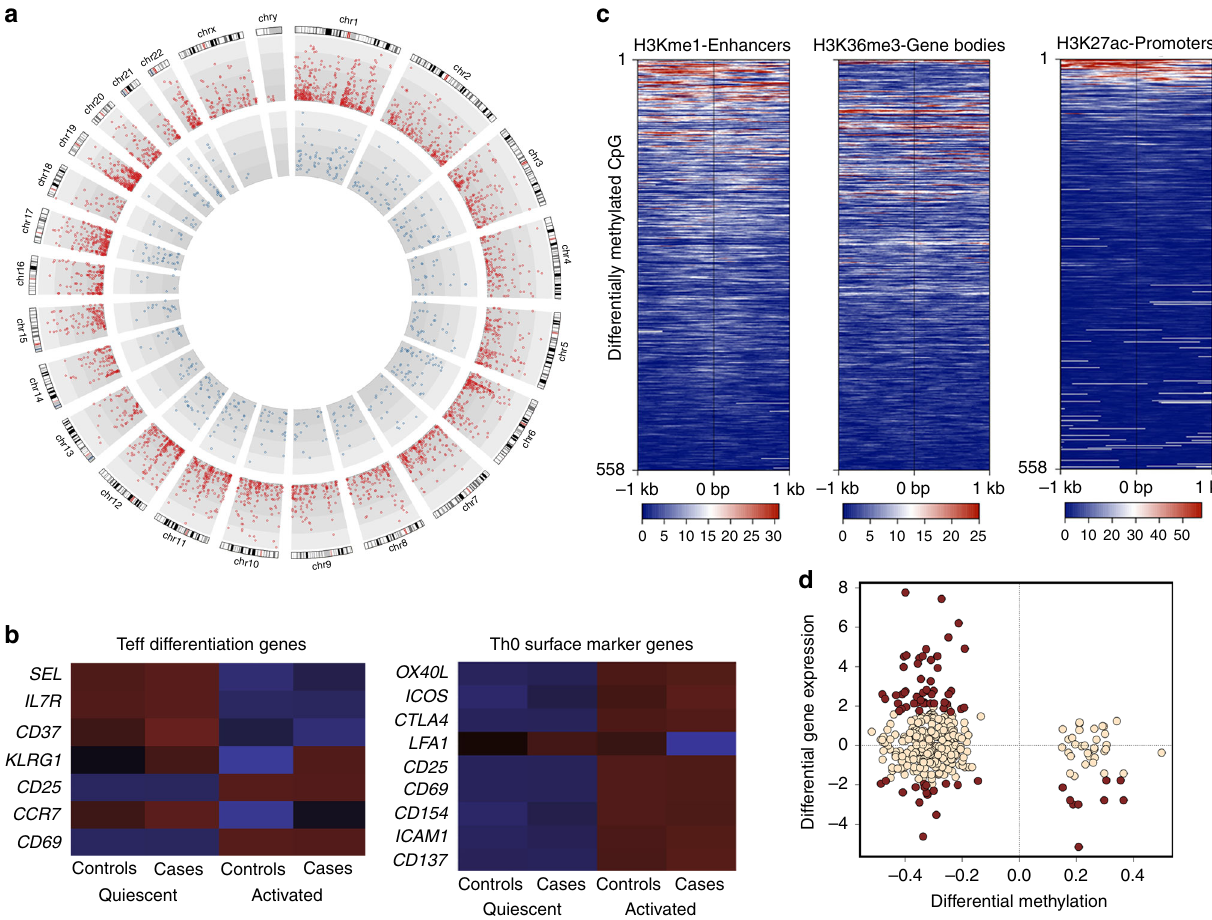
Fig. 2 Dynamic remodeling of epigenetic landscape in naive T cells following activation. a Genome-wide view of the – log 10 P value for 4154 differentially expressed genes (red circles) and 558 differentially methylated CpG (blue circles). b Heatmap of average gene expression (rows) for select genes. Cells are colored by the level of expression (blue, low; red, high). c Heatmap shows differentially methylated CpGs by genomic location ( y -axis) relative to distance from transcriptional start sites ( x -axis). Each panel shows enrichment for speci fi c histone marks. d Relationship between differential methylation and gene expression for selected genes. X -axis shows the difference in expression (activated minus quiescent cells) as percent methylation (10 − 2 ). Y -axis shows the log 2 fold change. Points in red were signi fi cantly differentially methylated and expressed (remodeled genes) at a genome-wide level. Teff: